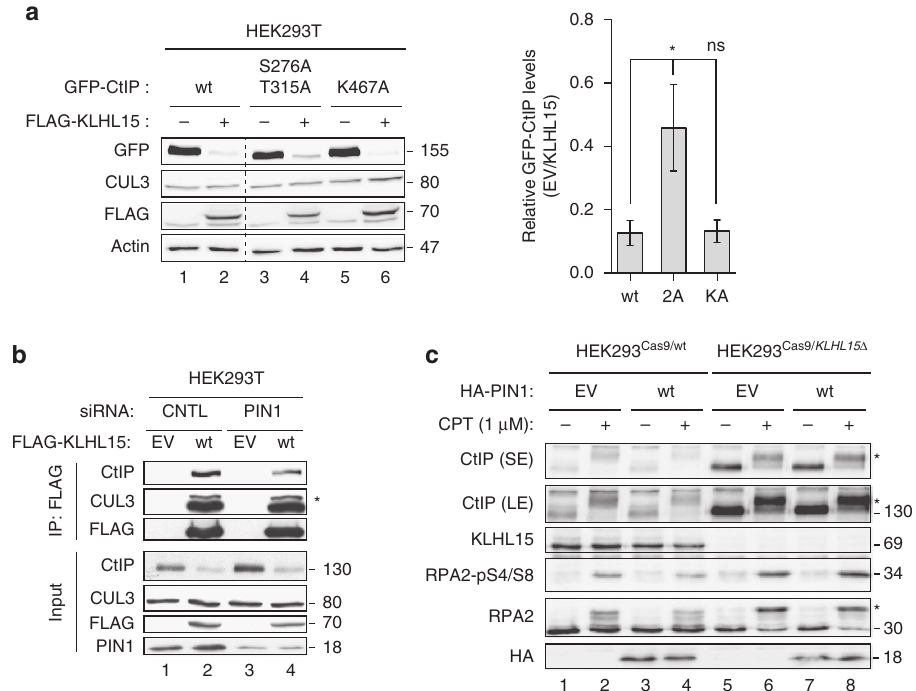
Figure 8 | PIN1 isomerase facilitates KLHL15-dependent degradation of CtIP. ( a ) HEK293T cells were cotransfected with FLAG-KLHL15 and either GFP-CtIP-wt, -S276A/T315A (2A, defective in PIN1 interaction), or -K467A (KA, defective in Cdh1 interaction) expression constructs. Forty-eight